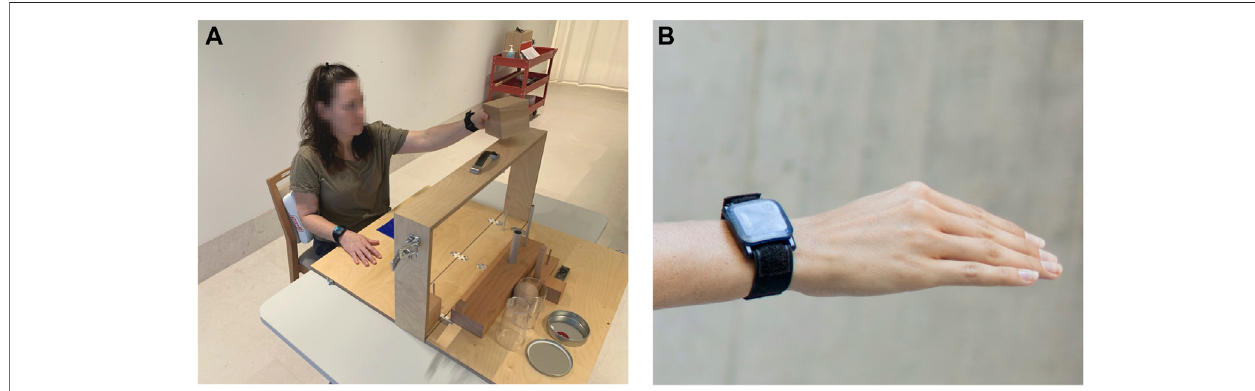
FIGURE 1 | (A) A participant performing ARAT task 1, which is part of the grasp domain. The task is to grasp a wooden block (10 cm in size) at the start position (blue patch on the table) and to put it on the shelf in front of the subject. (B) Close-up of the inertial sensor attached to the